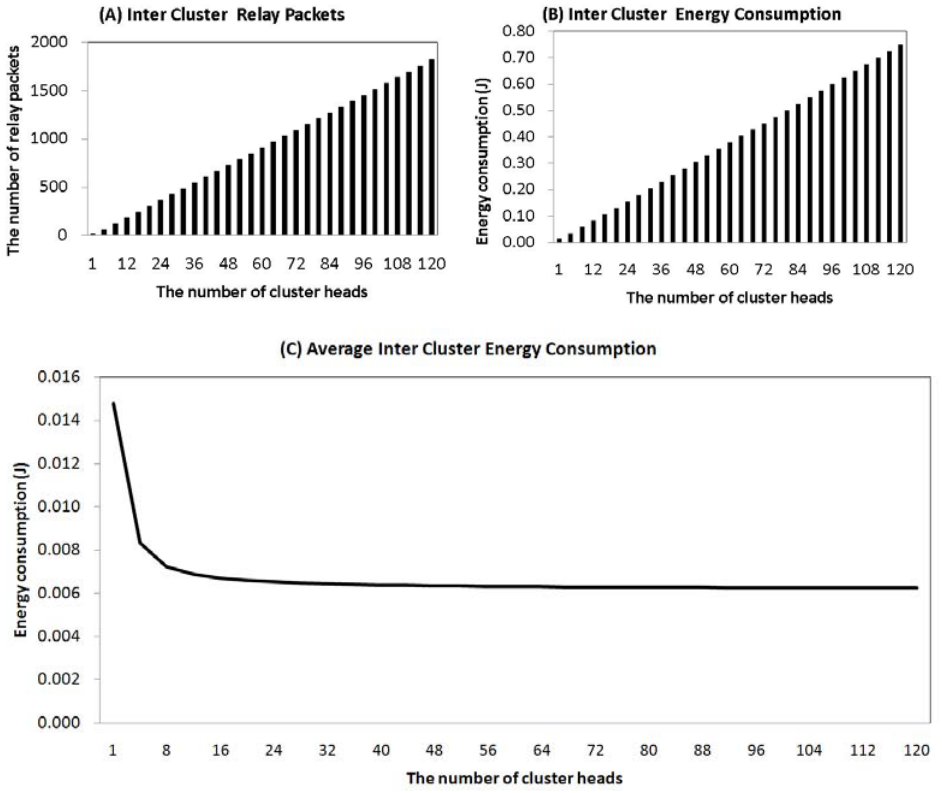
Figure 3. Inter-Cluster. (A) Inter-cluster relay packets, ( B ) Inter-cluster energy consumption, (C) average inter-cluster energy